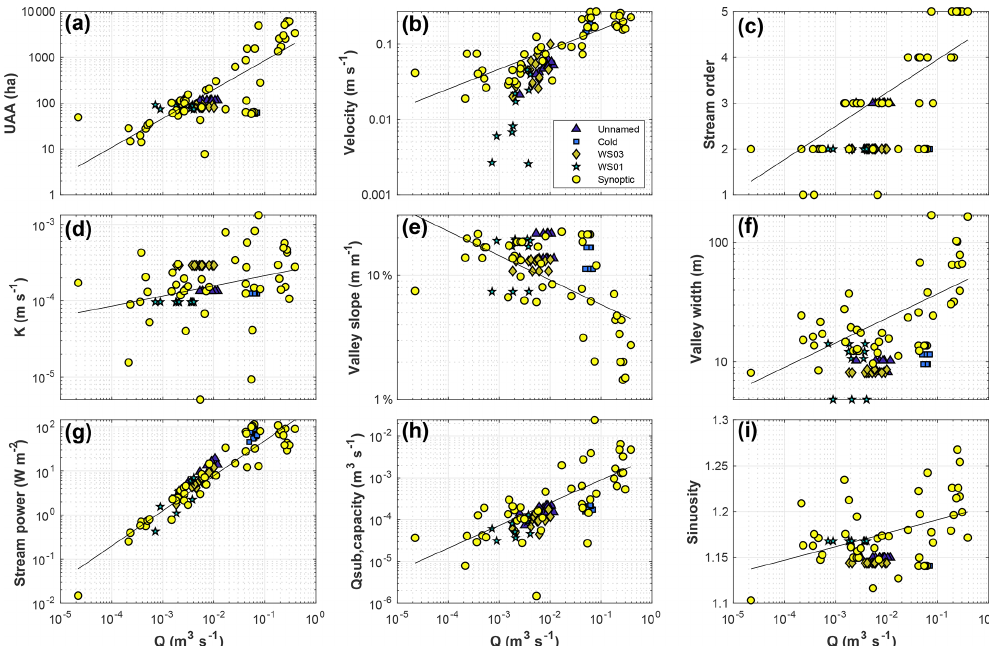
Figure 3. For synoptic data (yellow circles), discharge exhibits a significant, monotonic trend with all other site variables considered (Mann– Kendall test, p< 0 . 05). Pairwise MK test results for all site characteristic pairs (i.e., all y axis variables presented above) exhibit significant trends for all combinations ( p< 0 . 05). The solid black line shows the best-fit power-law regression for each panel. Data from unnamed creek (triangles, Cold creek (squares), WS03 (diamonds), and WS01 (stars) show the repeated injections through baseflow recession for each headwater catchment. See Supplement Figs. S1 and S2 for similar plots with HYP POT and UAA on the x